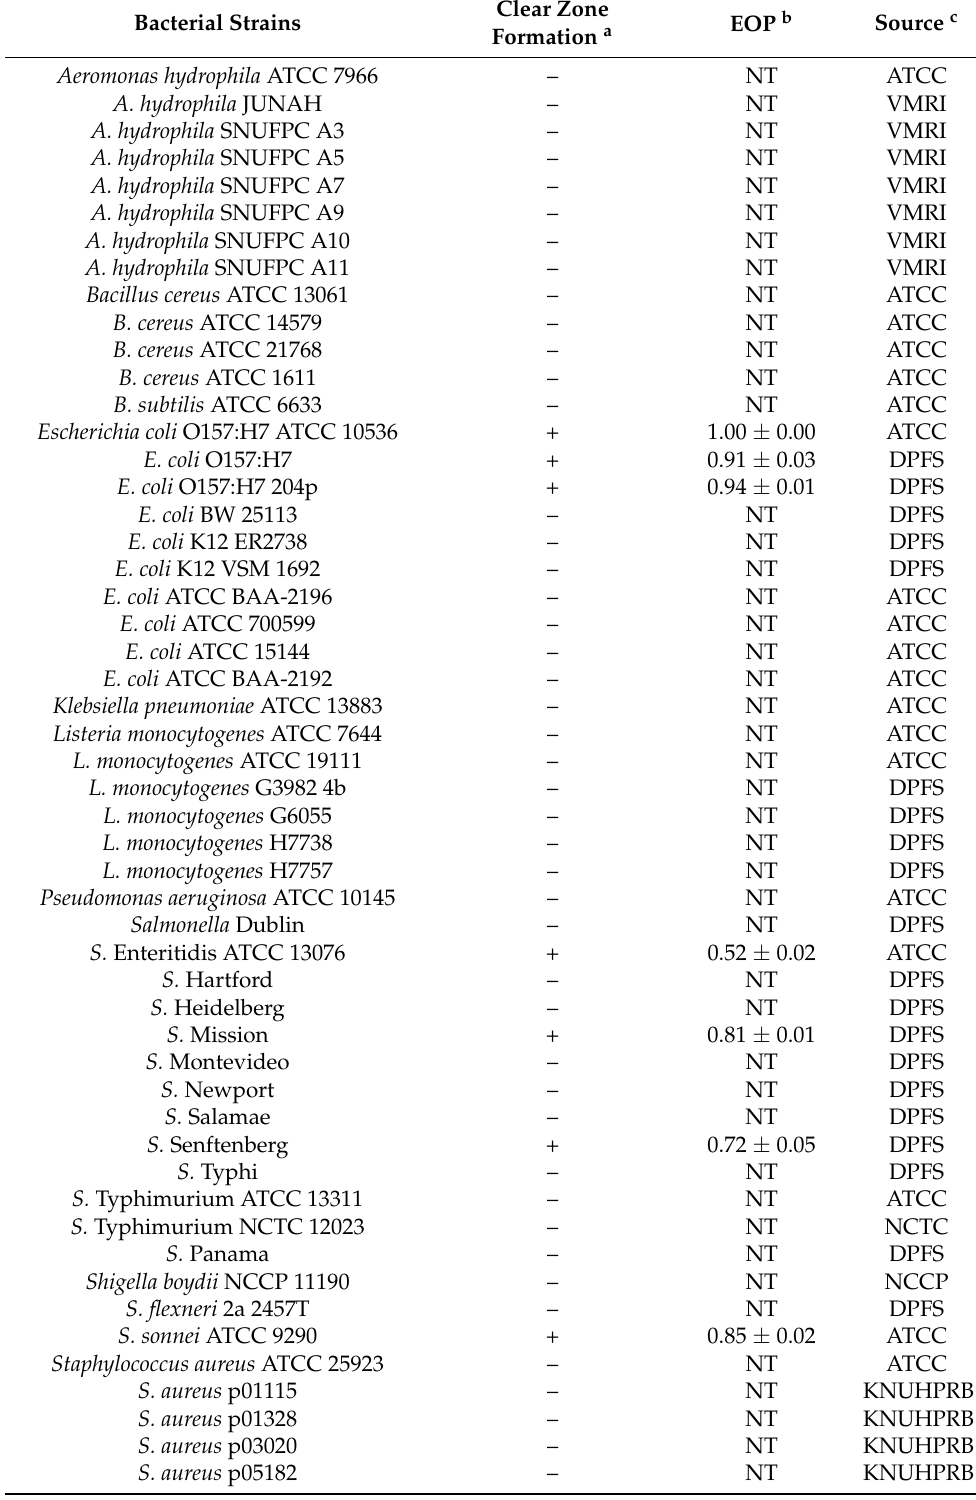
Table 1. Specificity and efficiency of plating of KFS-EC3. Bacterial Strains